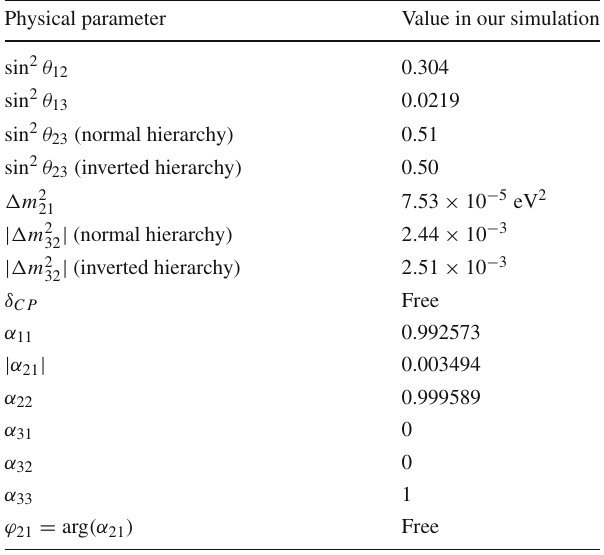
Table 1 Parameters used in our simulation Physical parameter